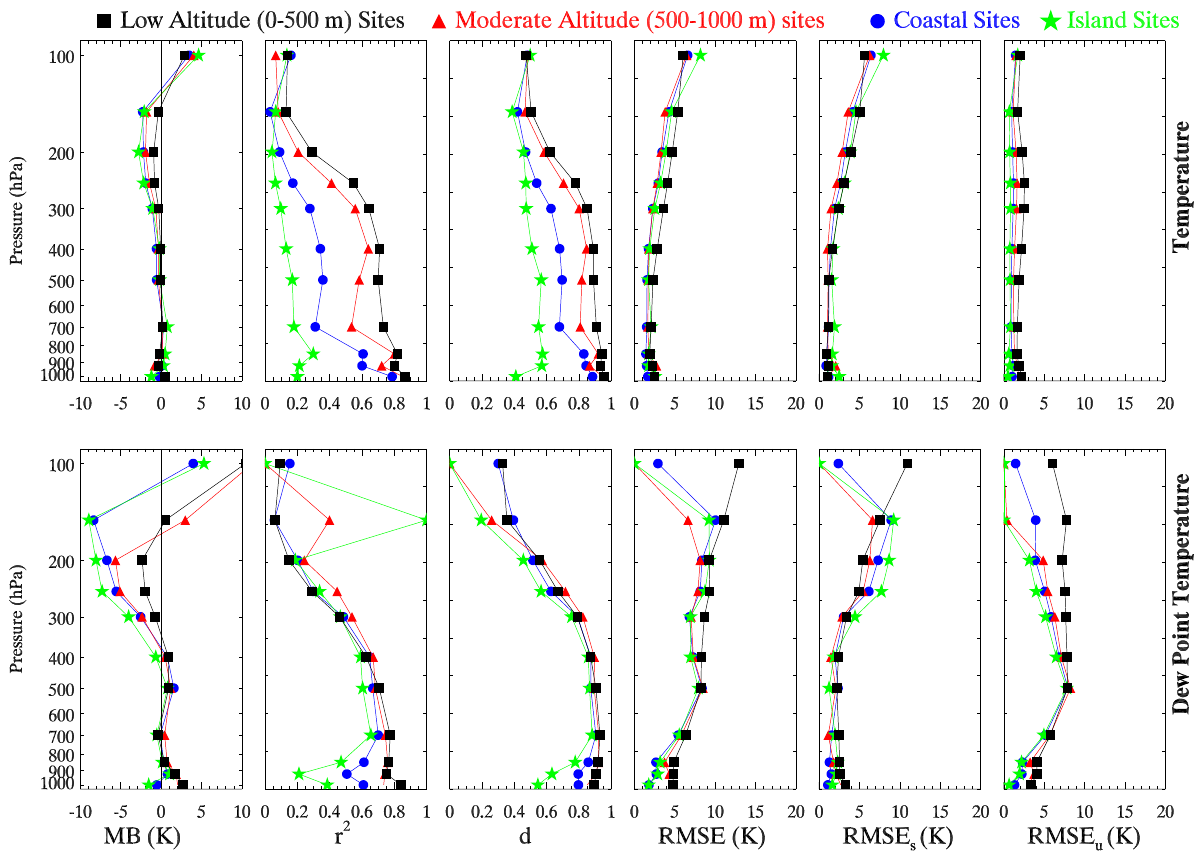
Fig. 12. Vertical profiles of the statistical metrics for temperature (top panel) and dew point temperature (bottom panel) at all the sites belonging to low altitude, moderate altitude, coastal and island sites. Average profiles of the statistical metrics for each site category are also shown. The dotted lines represent the profiles for individual sites and solid lines connected by symbols represent the respective average